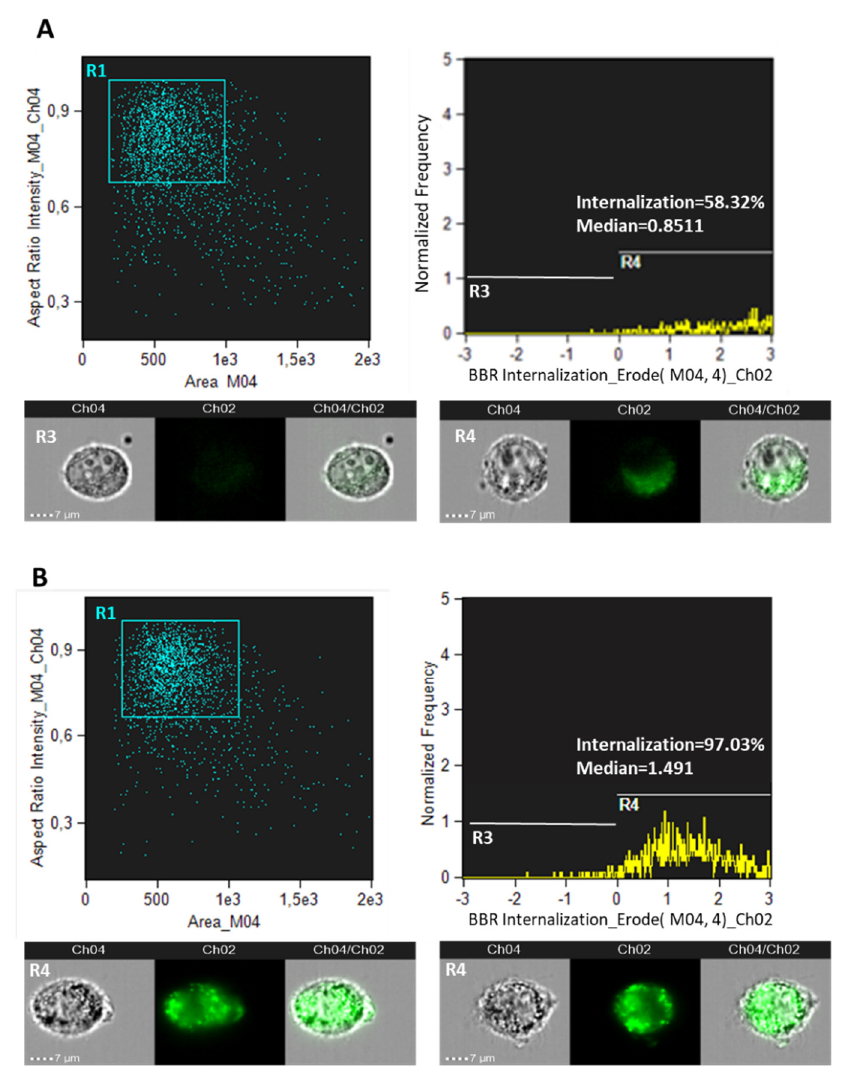
Figure 2. BBR cellular internalization. Amnis ImageStream MkII flow cytometry analysis of BBR (200 μ g/mL for 4 h) internalization in normal rat astrocytes ( A ) and in T98G cells ( B ) analyzed after 24 h p.t. Trypsinized cells were analyzed for bright field (Ch04) and for BBR fluorescence (Ch02) at 60× magnification. Percentages of focused cells with BBR internalization spots and Internalization Erode median parameters are reported. BBR internalization was analyzed by “Internalization” wizard with the following gating strategy: single cells were gated (using Area/Aspect Ratio Intensity, R1); R1 was then gated for focused cells using the “Gradient-RMS” feature and finally Ch2 intensity was measured with “Internalization” feature and an “Erode” mask applied. R2 gate (not shown) identified focused cells. Examples of cell images of R3 (negative control, i.e., cells without BBR) and R4 gates are shown.